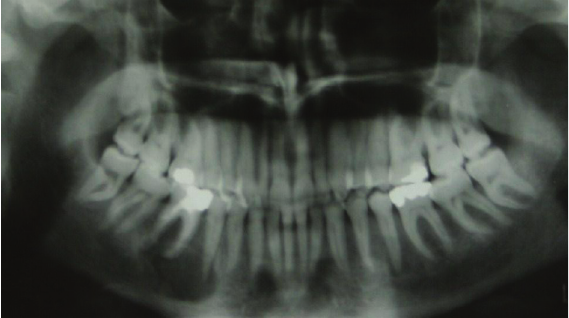
Figure 1: (December 12, 2000) X-ray of the maxilla that highlighted a bony rarefaction